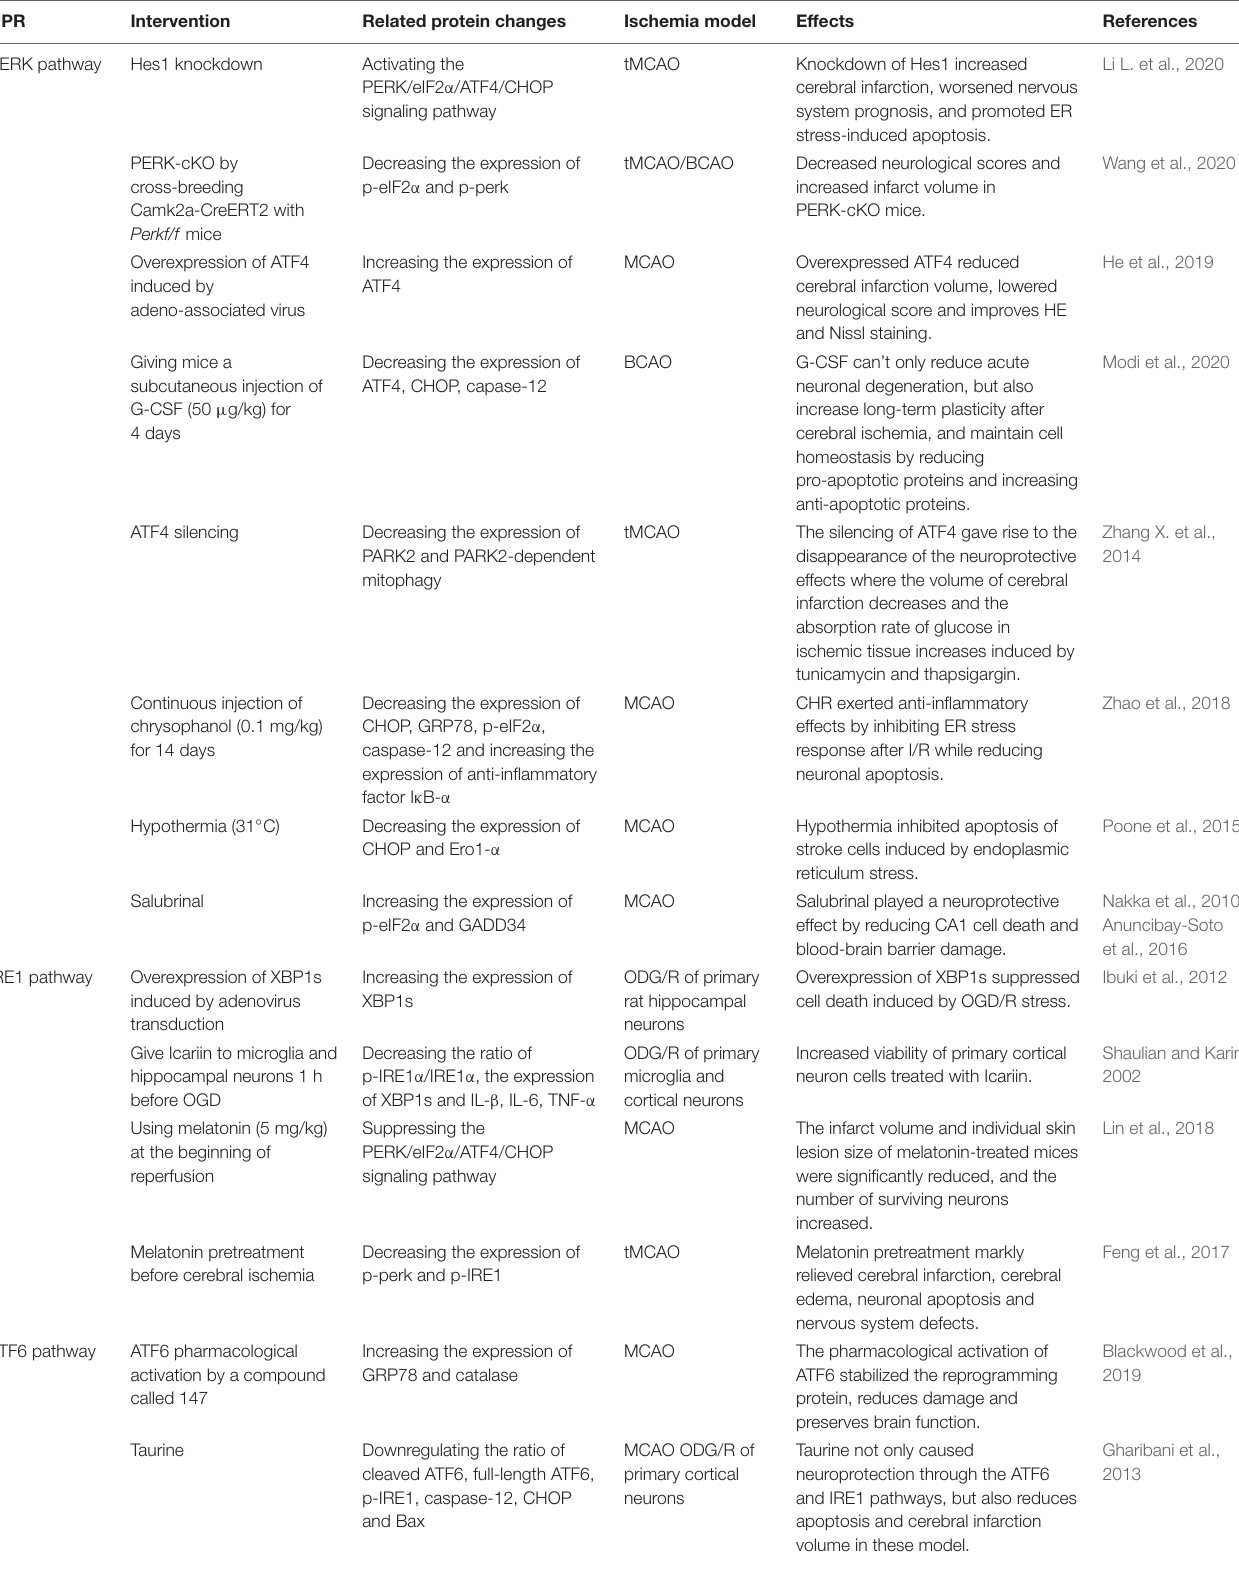
TABLE 1 | Studies on intervention of UPR in cerebral